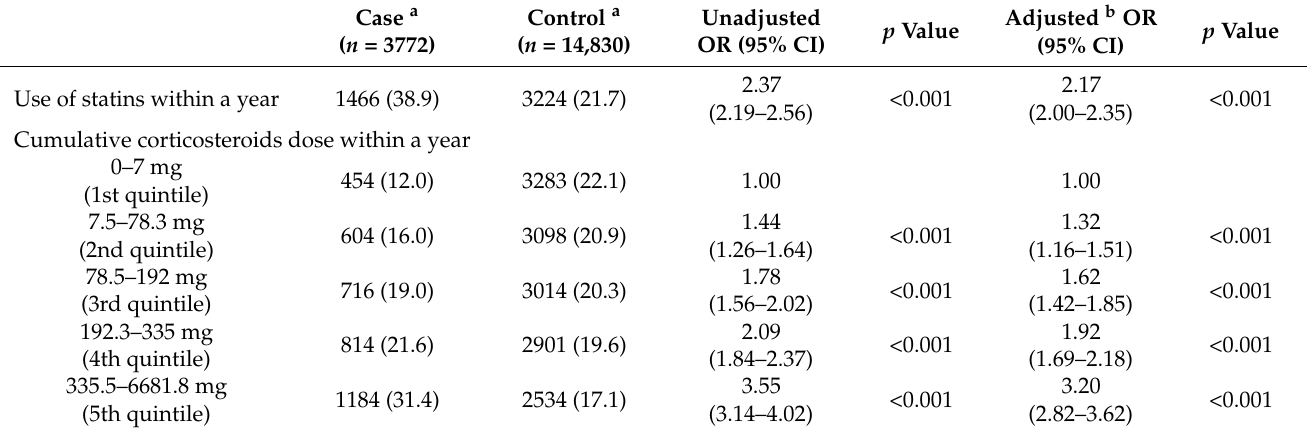
Table 2. Risk of incident DM according to statins and corticosteroids.